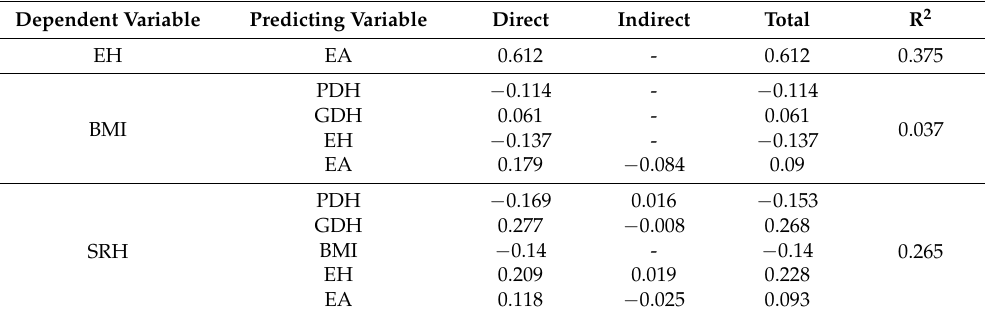
Table 3. Direct and indirect